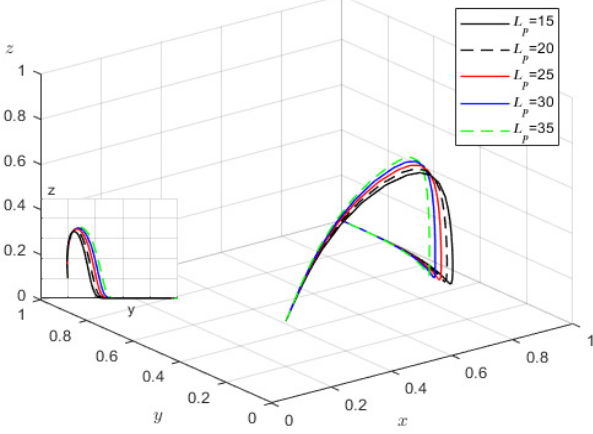
Figure 5. The impact of enterprises’ compensation amount.